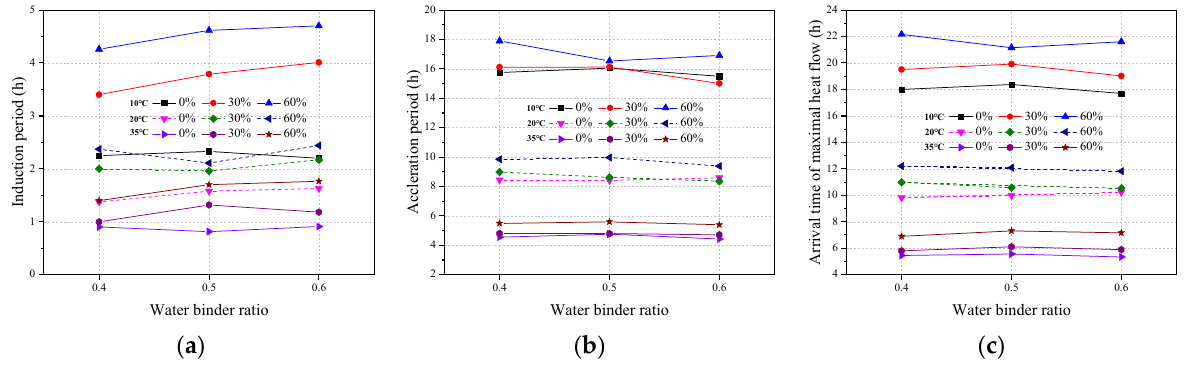
Figure 5. Time variables at different temperatures. ( a ) end time of induction period; ( b ) duration of acceleration period; ( c ) arrival time of exothermic peak.